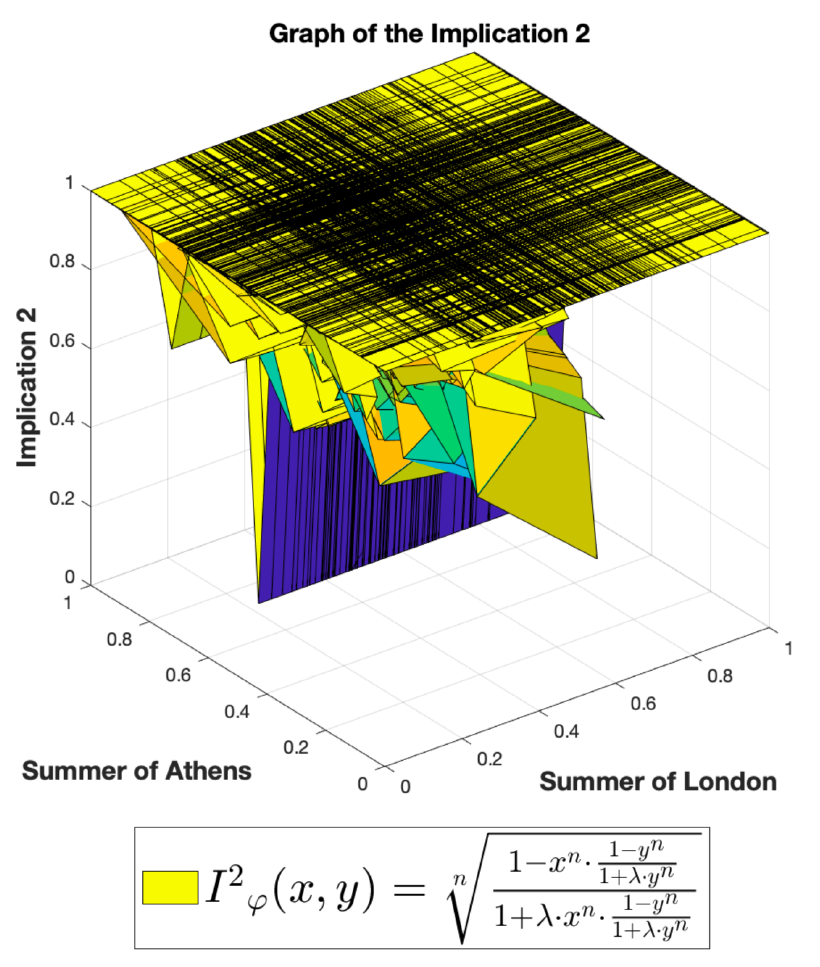
Figure 2. Graph of the Implication